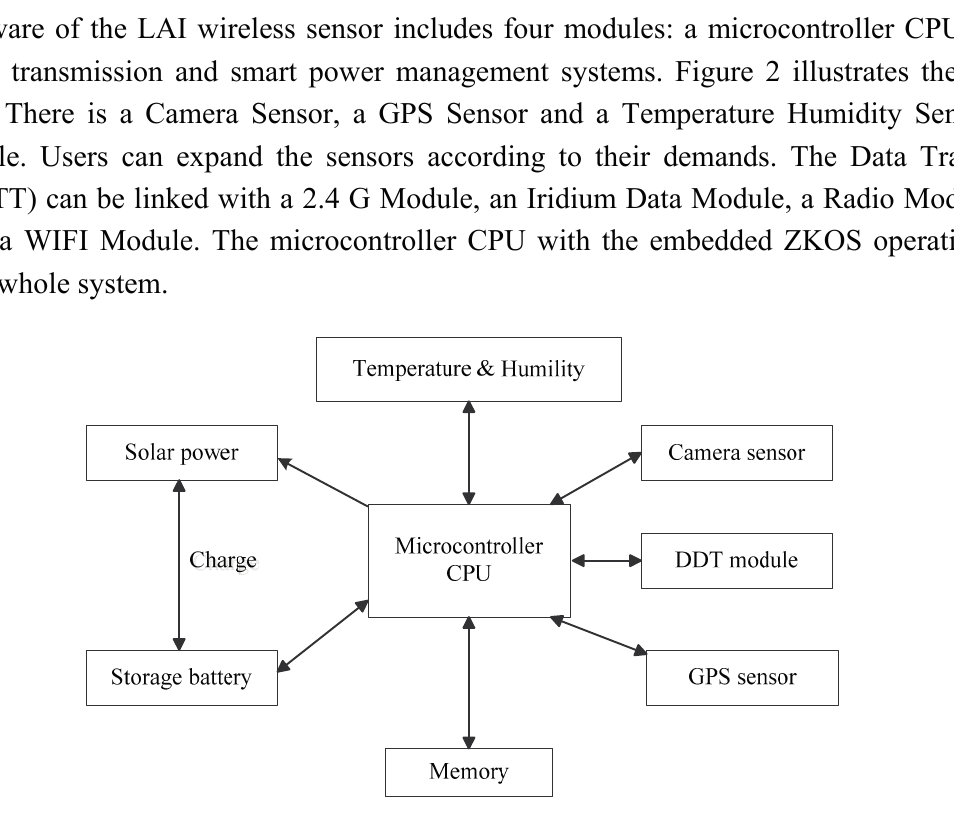
Figure 2. Hardware components of the